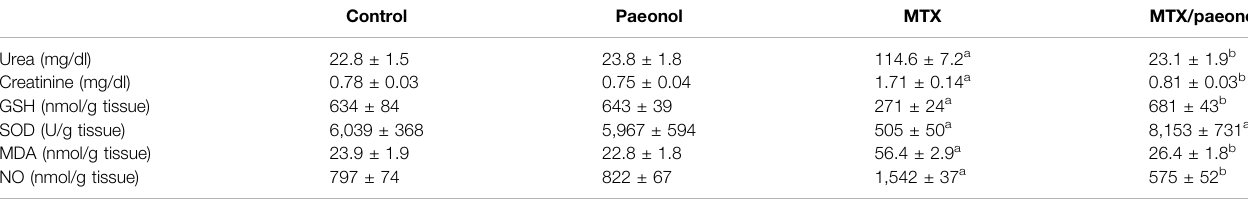
TABLE 1 | Effect of paeonol on serum urea and creatinine, and renal oxidative stress markers in methotrexate (MTX)-treated rats.